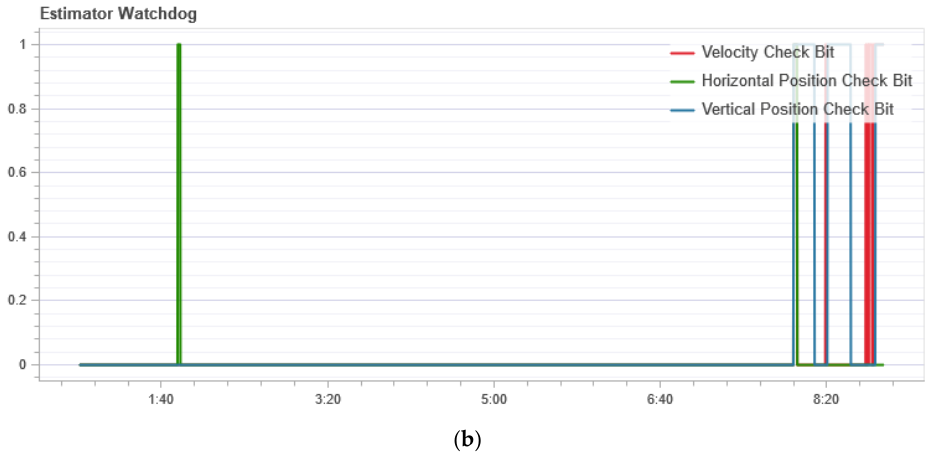
Figure 9. The state of the system performance evaluator: ( a ) In the normal mode; and ( b ) during a GPS attack. Figure 10 shows the result of measuring the processor load. It shows that in the normal mode of UAV flight, the central processor of the flight controller is loaded at its peak by 45%, and during the attack, the load is not stable and reaches 80% at its peak, which means that the drone requires more computation during the attack to maintain its flight stability.